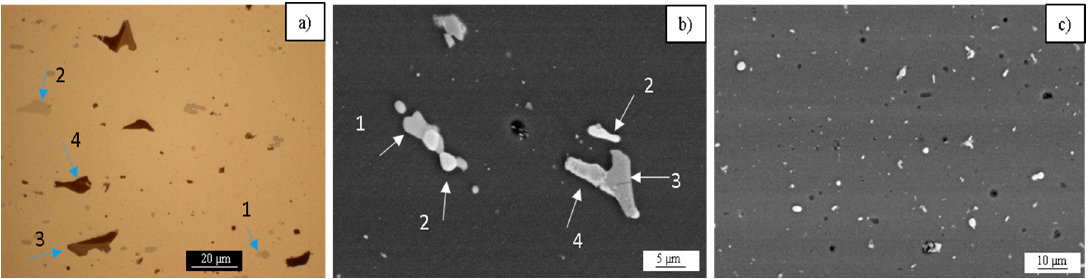
Figure 2. Optical ( a ) and Scanning Electron Microscope (SEM) micrographs ( b , c ) of AA2024-T4 substrate ( a , b ) and electrode ( c ).